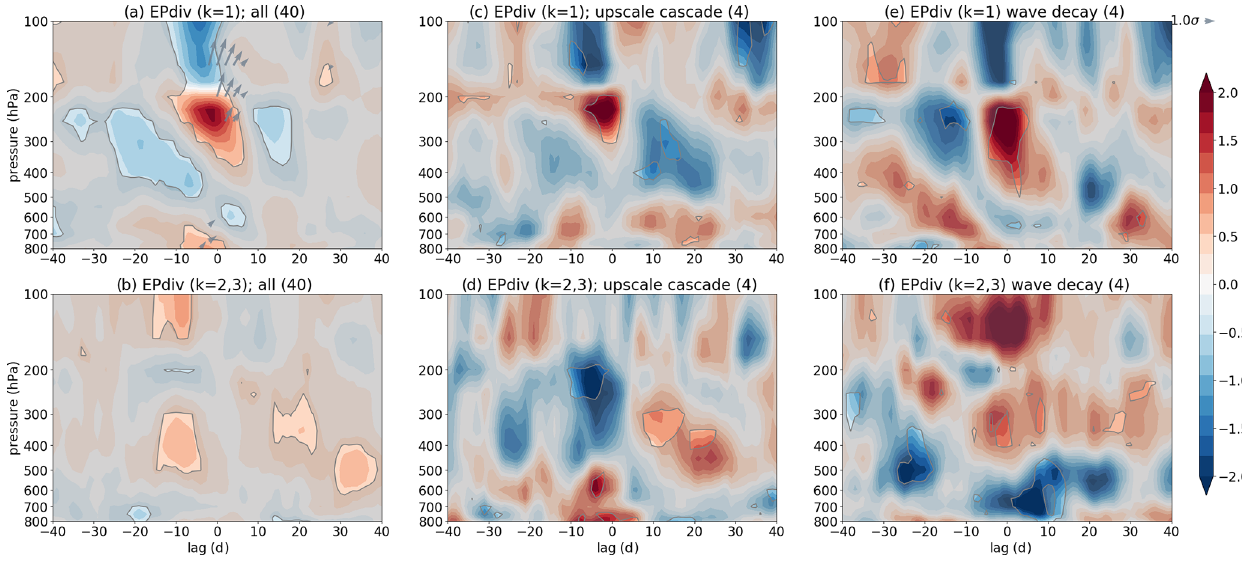
Figure 5. Similar to Fig. 4 but for ERA-20C data. Note that panels (a, c, e) represent the same quantities for k = 1 waves and panels (b, d, f) represent the same quantities for k = 2, 3 waves instead of synoptic waves. Data are averaged between 45 and 75 ◦